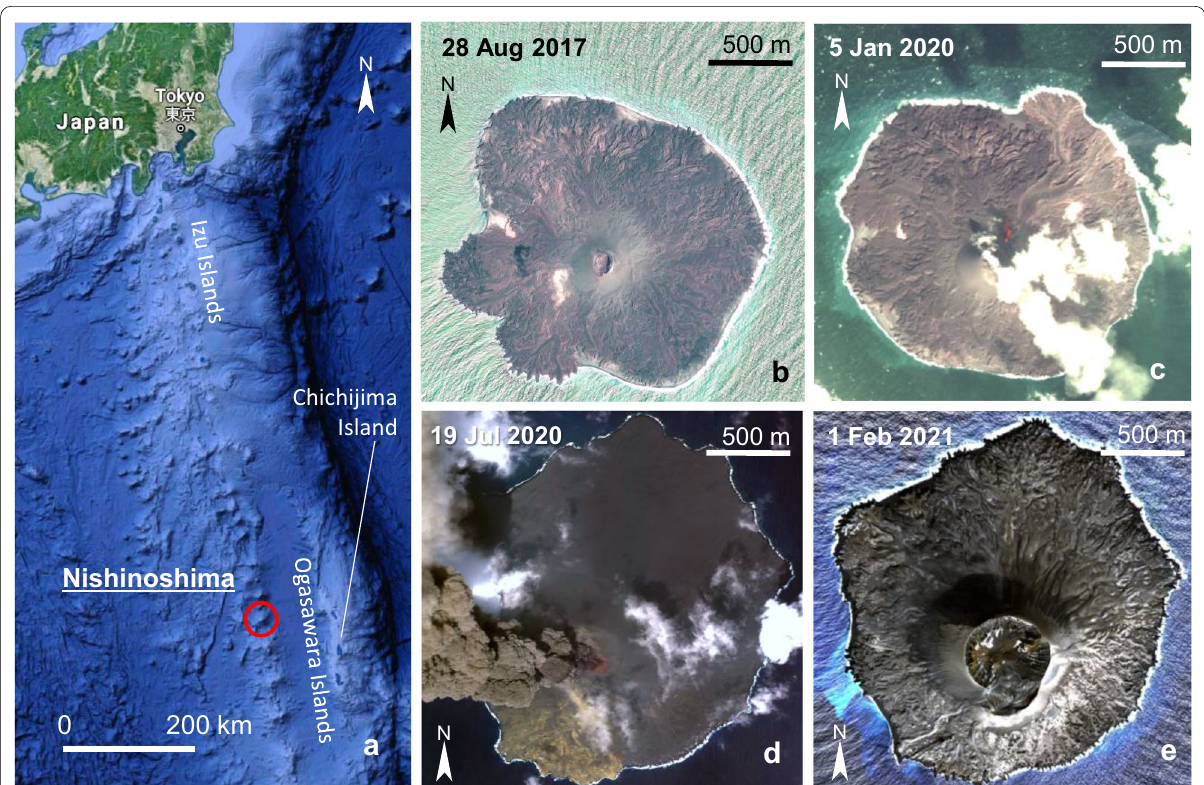
Fig. 1 a Location of Nishinoshima ( reproduced from Google Earth). b Pleiades images of Nishinoshima before the Episode 4 activity (28 August 2017). c SPOT-6/7 image taken on 5 January 2020. d WorldView-3 image taken on 19 July 2020. e WorldView-2 image taken on 1 February